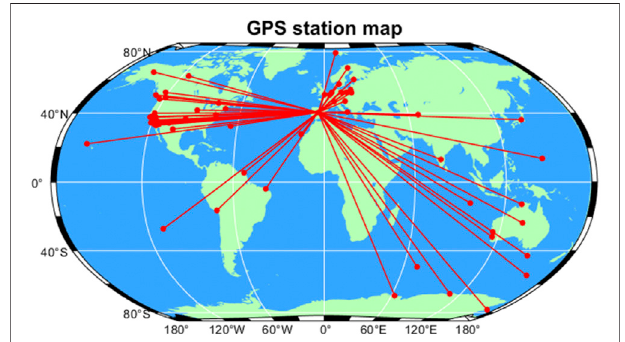
FIGURE 3 | Diagram of the distance between VILL and the remaining points. The VILL site in 1995 is taken as an example. The red spot represents the location of each site, and the line segment represents the distance between the sites. The distance between the pairs of receivers at the beginning and the end of the year is calculated, and the change in this value is calculated. The average radius change in 1995 is − 2.4 mm.